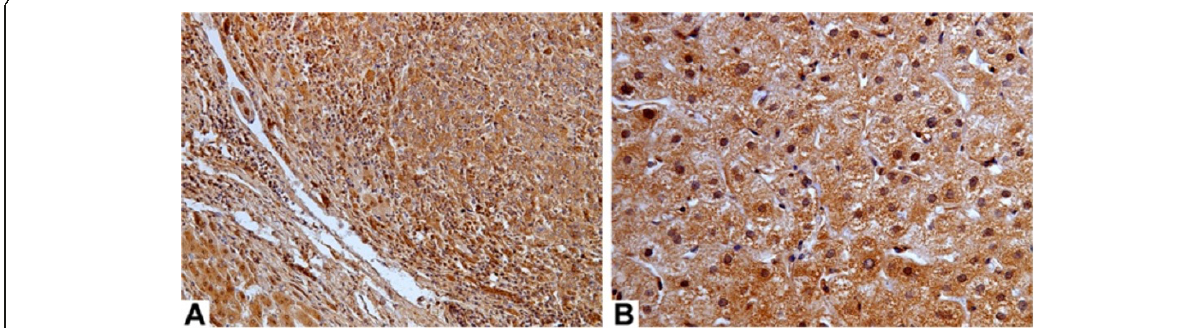
Figure 3 A case of hepatocellular carcinoma (A) with adjacent non-neoplastic liver tissue (B) showed strong and diffuse arginase-1 staining (A,B, immuoperoxidase, original magnification x200,